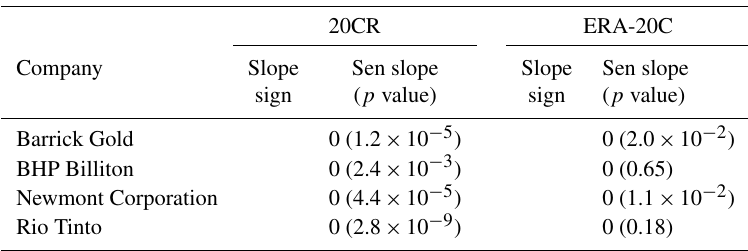
Table B2. Mann–Kendall test results for the count of the number of extreme 1-day extreme rainfall event with a 100-year return level on four mine portfolios, using both the NOAA and ECMWF climate